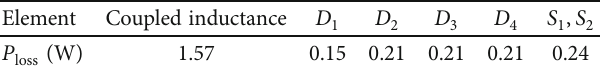
Figure 19: Loss distribution of the converter.